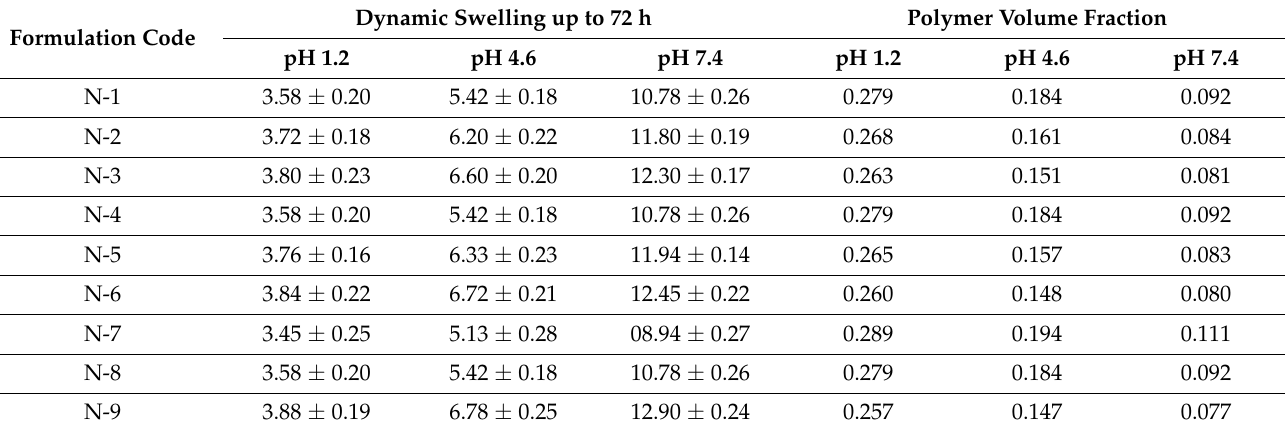
Table 1. Dynamic swelling and polymer volume fraction of Cs/SpsCpAca hydrogels. Formulation